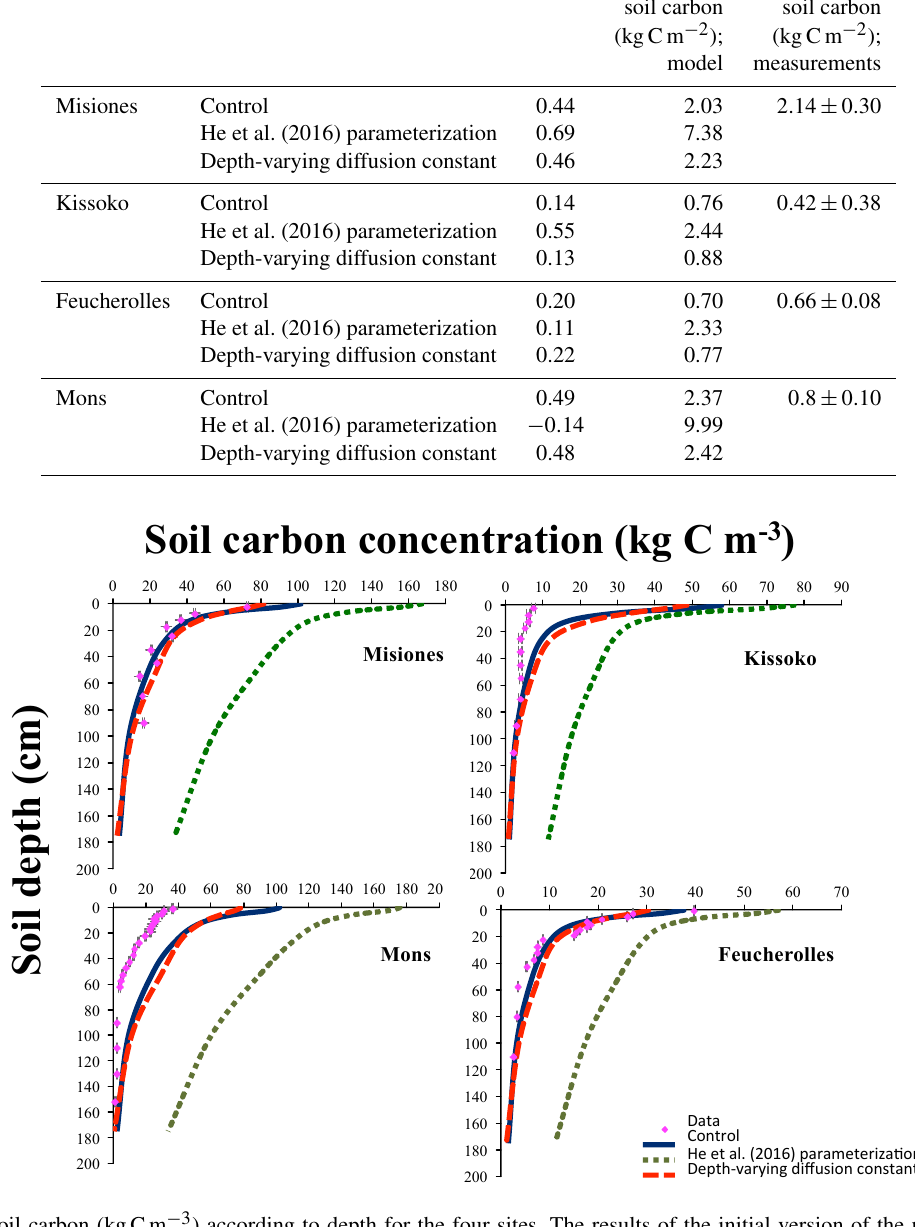
Figure 3. Total soil carbon (kgCm − 3 ) according to depth for the four sites. The results of the initial version of the model ORCHIDEE- SOM- 14 C (Control), those from the version including the modification according to He et al. (2016) (He et al., 2016, parameterization) and diffusion varying according to depth (Depth-varying diffusion constant) are